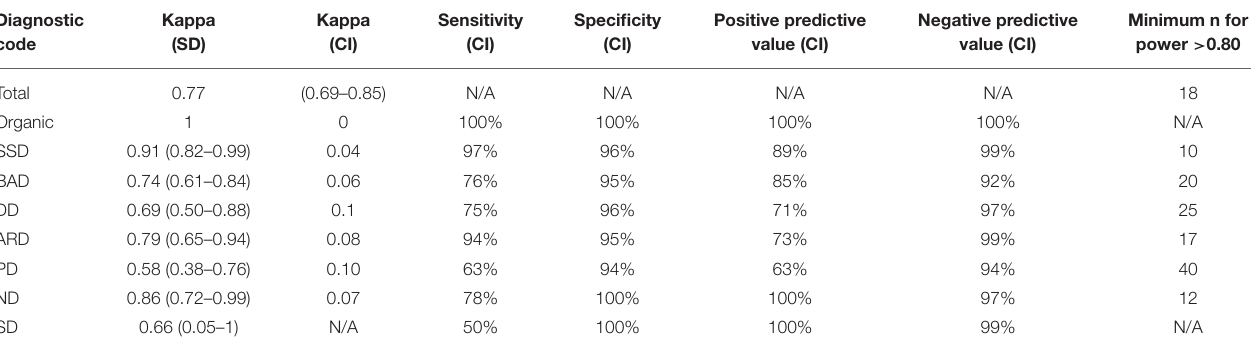
TABLE 4 | Agreement report of prototype vs. ICD-10 operational-based diagnosis, by diagnostic code. Diagnostic code